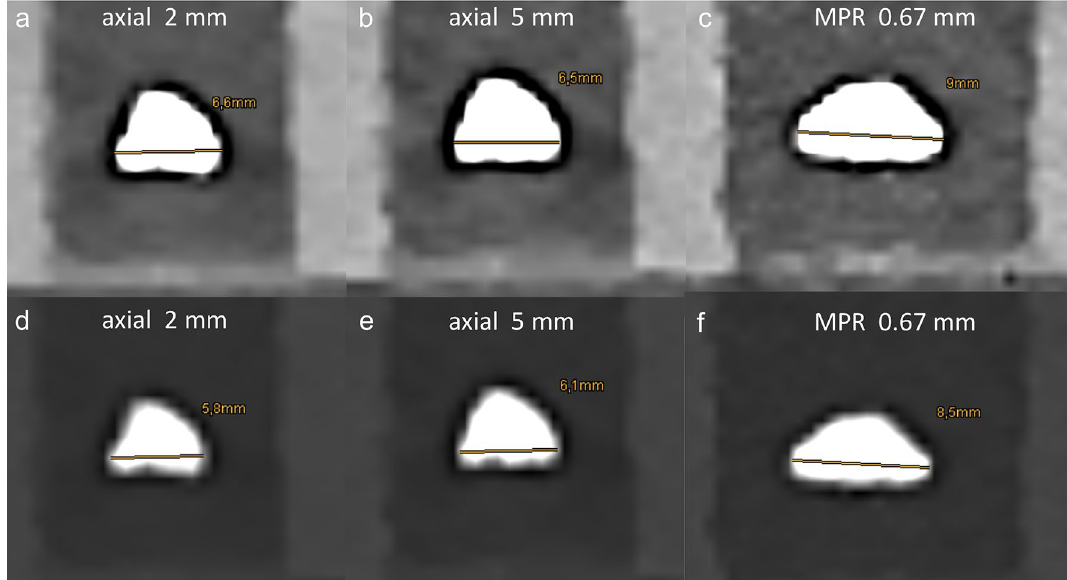
Figure 3. Computed tomography images reconstructed with a model-based iterative reconstruction algorithm of one kidney stone with a manually measured longest diameter of 8.61 mm, illustrating the influence of different image reformatation, slice thickness and window setting on size measurements ( A – F ). Irrespective of slice thickness, size measurements using axial reformatations underestimated true stone size ( A , B , E , F ), while measurements were higher using a soft-tissue window ( A – C ) vs. a bone window setting ( D – F ). Most accurate measurements were obtained using multiplanar reformatation with a bone window ( F